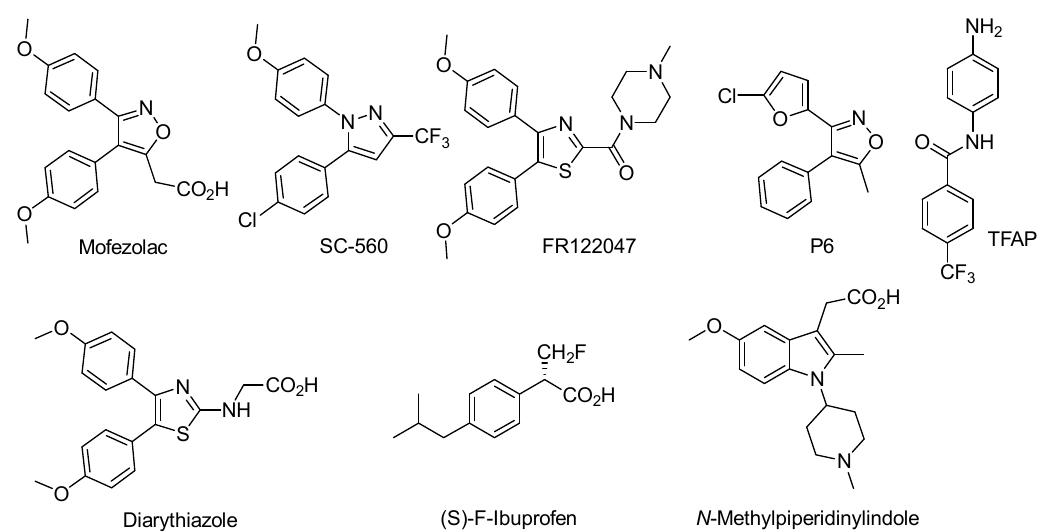
Figure 1. Representative COX-1 selective inhibitors with improved safety profile.